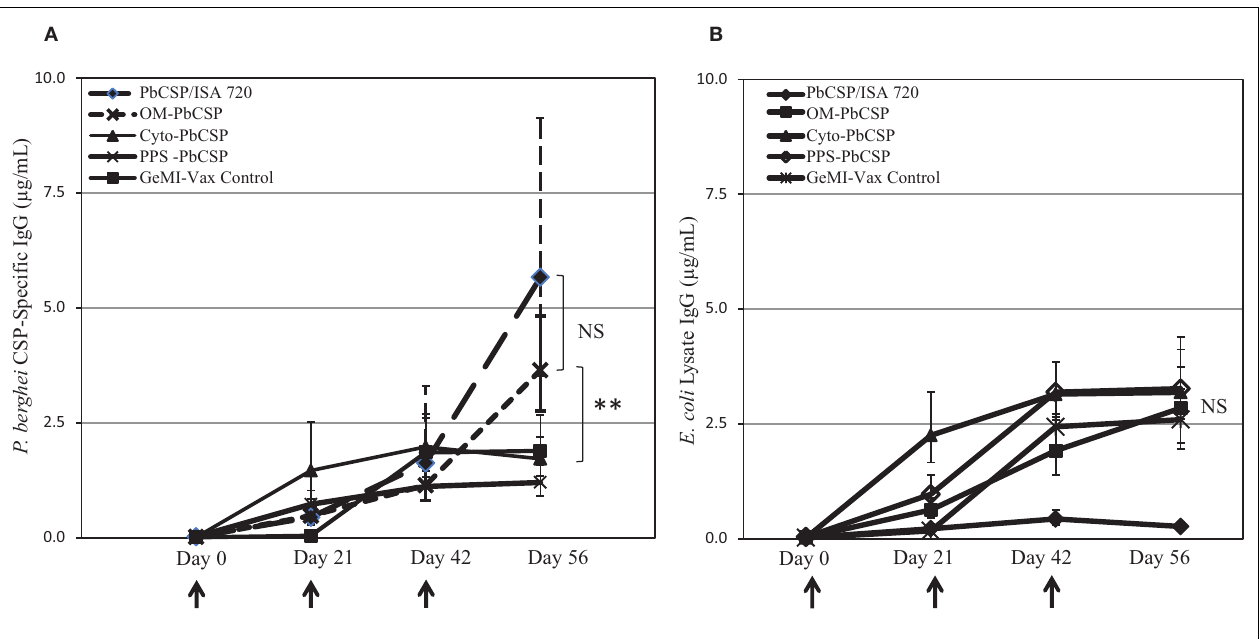
Data are expressed as geometric mean in µ g/mL of antigen-specific IgG ( n = 15 mice/group), and the error bars indicate the 95% confidence interval. NS denotes not statistically significant. Asterisk indicates statistical significance, ** p < 0.001; Kruskal–Wallace One-Way Analysis ofVariance on Ranks.